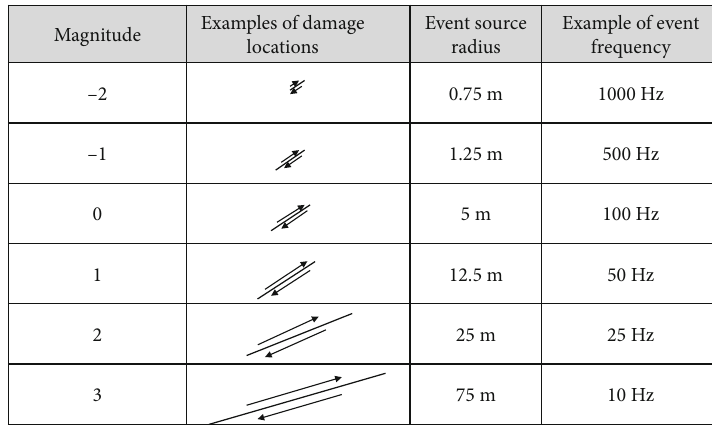
Figure 10: Examples of microseismic energy and failure displacement.